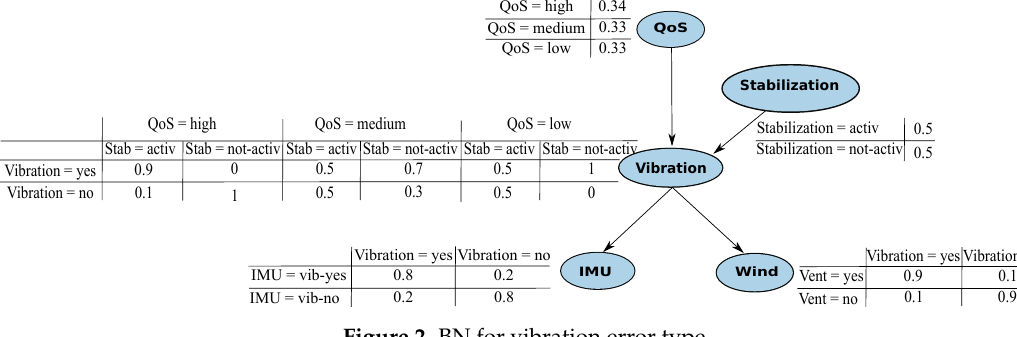
Figure 2. BN for vibration error type.